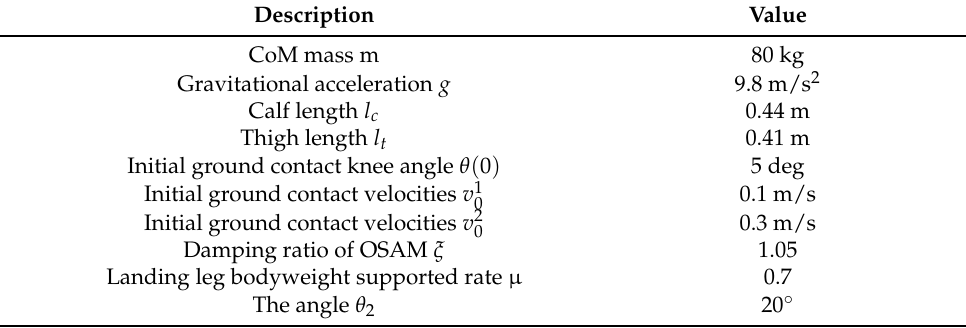
Table 1. Simulattion